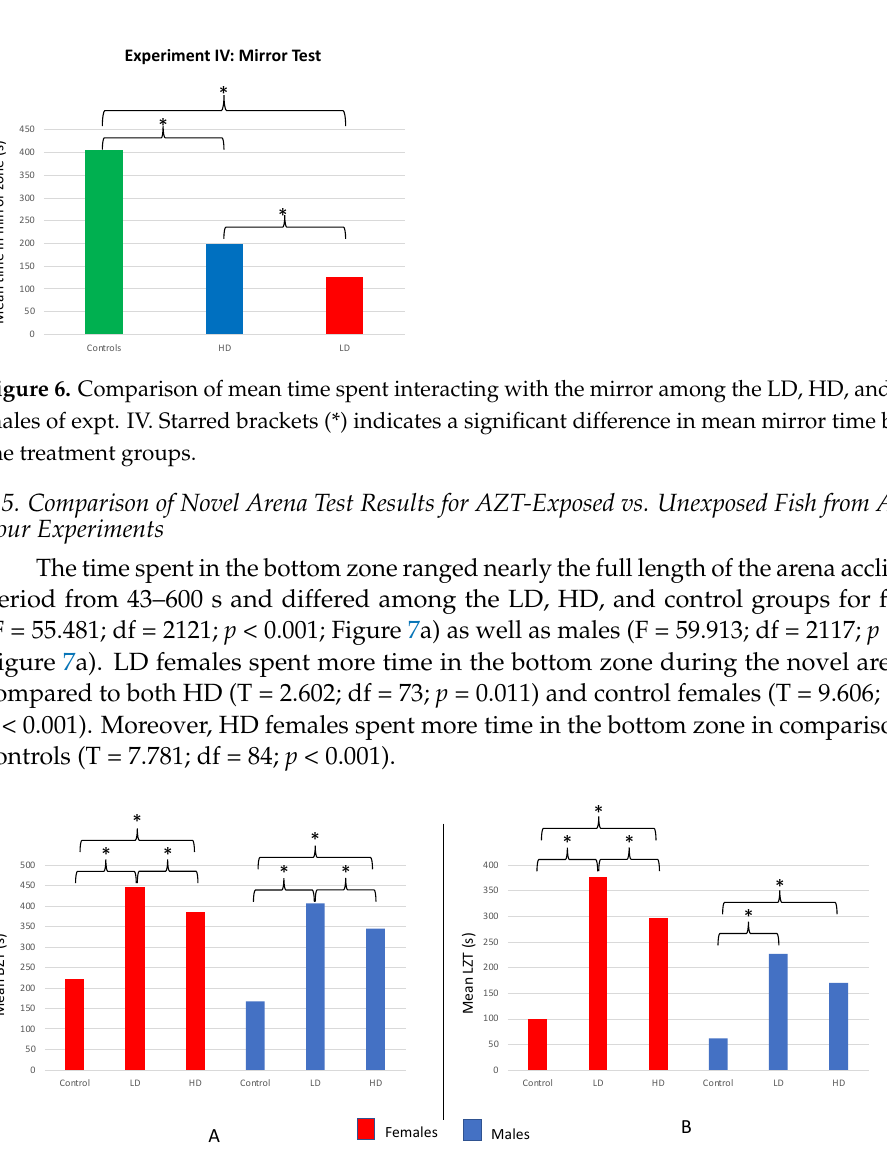
Figure 7. Comparison of ( A ) time spent in the bottom zone (BZT) and ( B ) latency to enter the top zone (LTZ) among the LD, HD, and control females (red) and males (blue) from expts. I-IV combined. Starred brackets (*) indicate a significant difference between the treatment groups (e.g., control females vs. LD females).